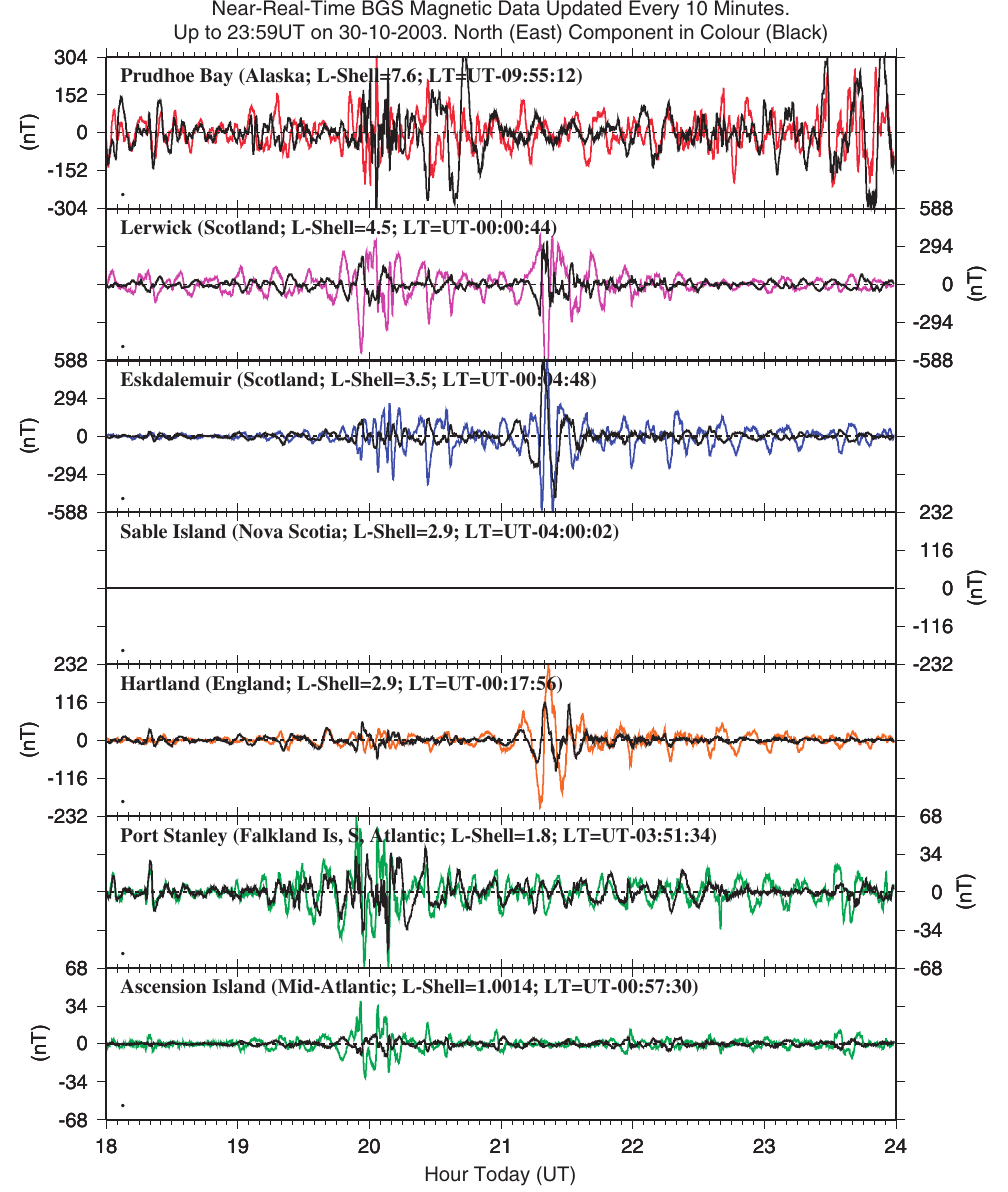
Fig. 9. Stack plot of filtered (2-1000 s) north (X, coloured line) and east (Y, black line) BGS observatory meas- urements during the 30th October 2003 magnetic storm, for six hours when the 3-hour magnetic activity index ap was sustained at its maximum of 400. Magnetic L -shell (McIlwain, 1961) and local time (LT) are noted for each observatory. Note that 1-second data from the Sable Island observatory were unavailable at this